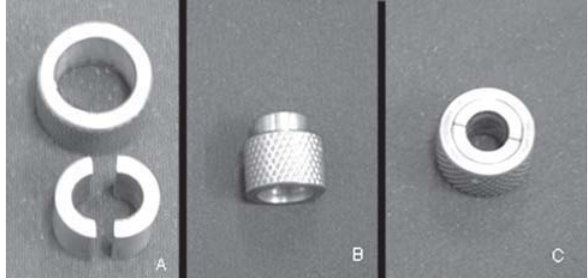
FIGURE 1- Matrix used for fabrication of the composite resin specimens. A) disassembled; B) attached; and C)